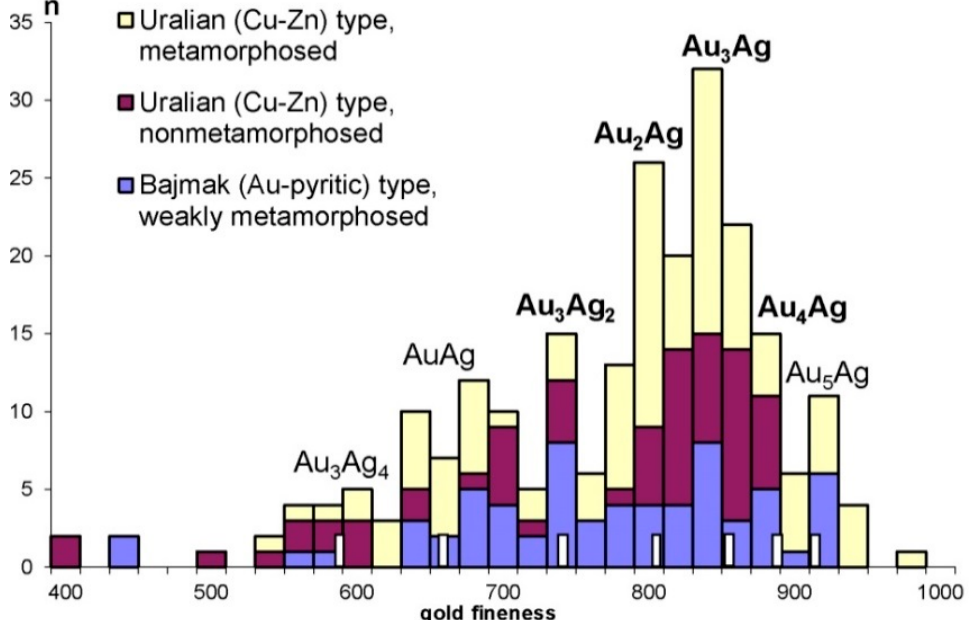
Figure 30. Composition range of native gold in massive sulphide ores of the Urals.